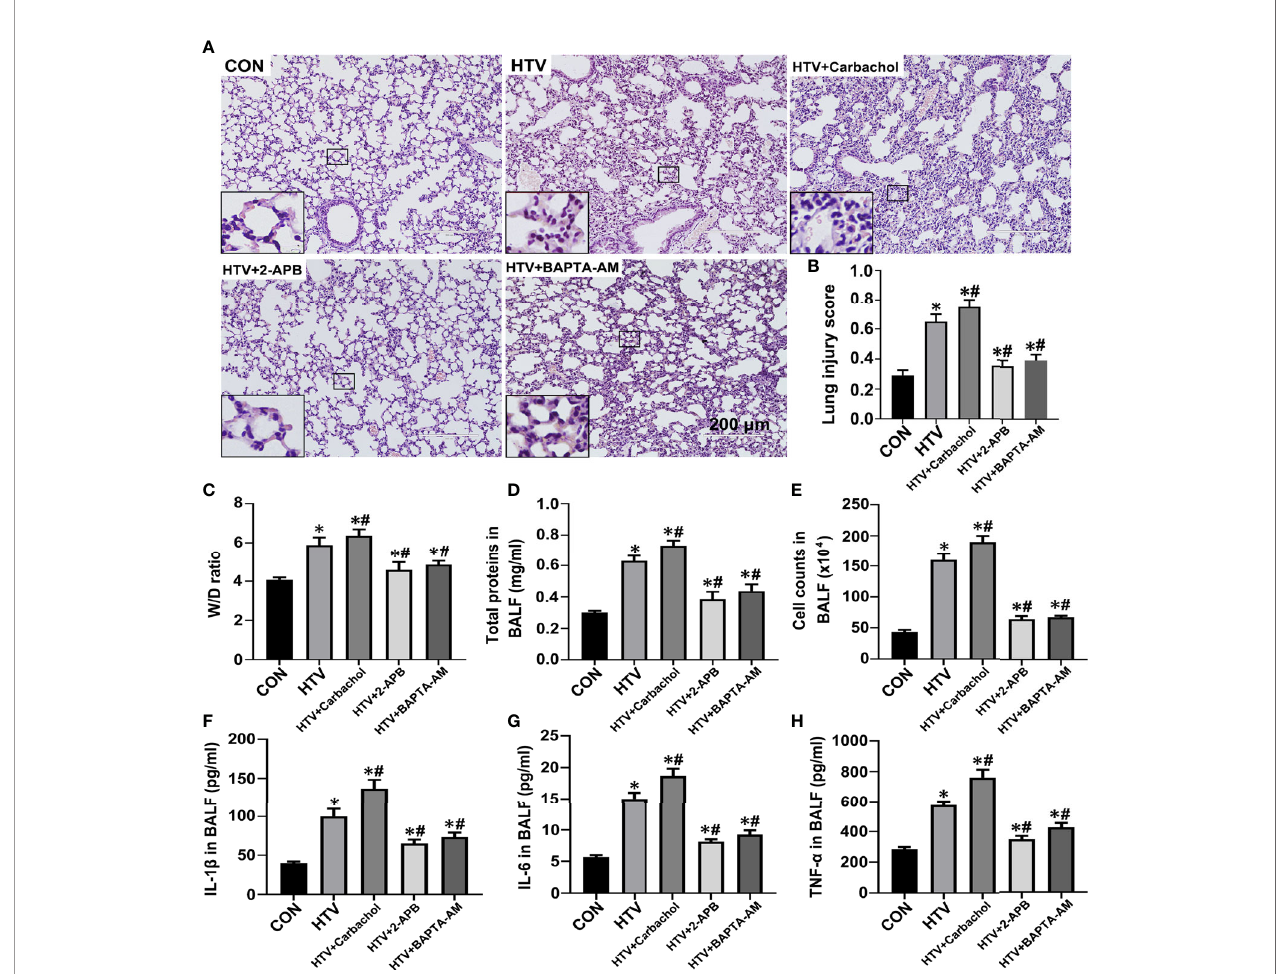
FIGURE 4 | Effects of carbachol, 2-APB and BAPTA-AM on HTV-induced pathological lung injury and in fl ammation. (A) H&E staining the histology of lung tissues from group CON, HTV, HTV+Carbachol, HTV+2-APB mice, and the HTV-treated mice pretreated with Ca2+ chelator BAPTA-AM (HTV+BAPTA-AM group). Scale bar: 200 m m. An inset picture was employed to show the indicated area at 4X magni fi cation. (B) Pathological scores were assessed by results of H&E staining. (C) Lung edema was assessed by determining the weight ratio between wet and dry lungs. (D) Total protein concentration in BALF. (E) In fi ltrated cell counts in BALF. (F – H) Levels of IL-1 b (F) , IL-6 (G) and TNF- a (H) in BALF. Data are expressed as means ± SD (n = 8 per group except for group HTV+ Carbachol (n=7), which has 1 mouse died unexpectedly and was removed from analysis). * P < 0.05 vs . CON group; # P < 0.05 vs . HTV